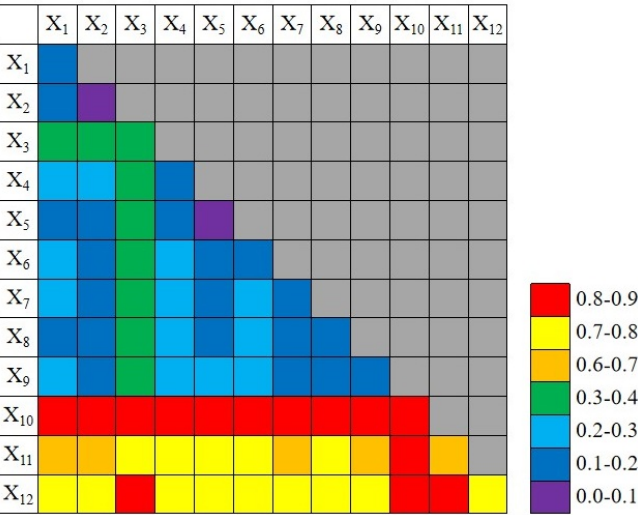
Figure 5. Factor interaction results (The meanings of di ff erent indicators are shown in Table 2).